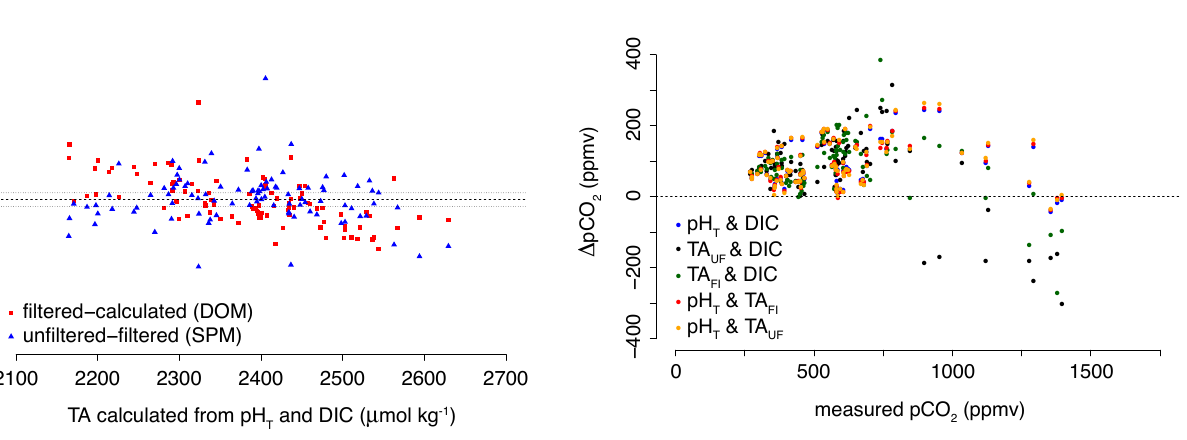
Figure A1. Differences in total alkalinity ( (cid:49) TA; µmolkg − 1 ) mea- sured on unfiltered and filtered (0.45µm) samples (blue triangles; representing the effect of particles) and between TA measured on filtered seawater and TA calculated from DIC and pH T (red squares; representing potential organic alkalinity), plotted as a function of TA calculated from DIC and pH T . The dotted lines indicate the typi- cal standard deviation of the difference between two measurements.